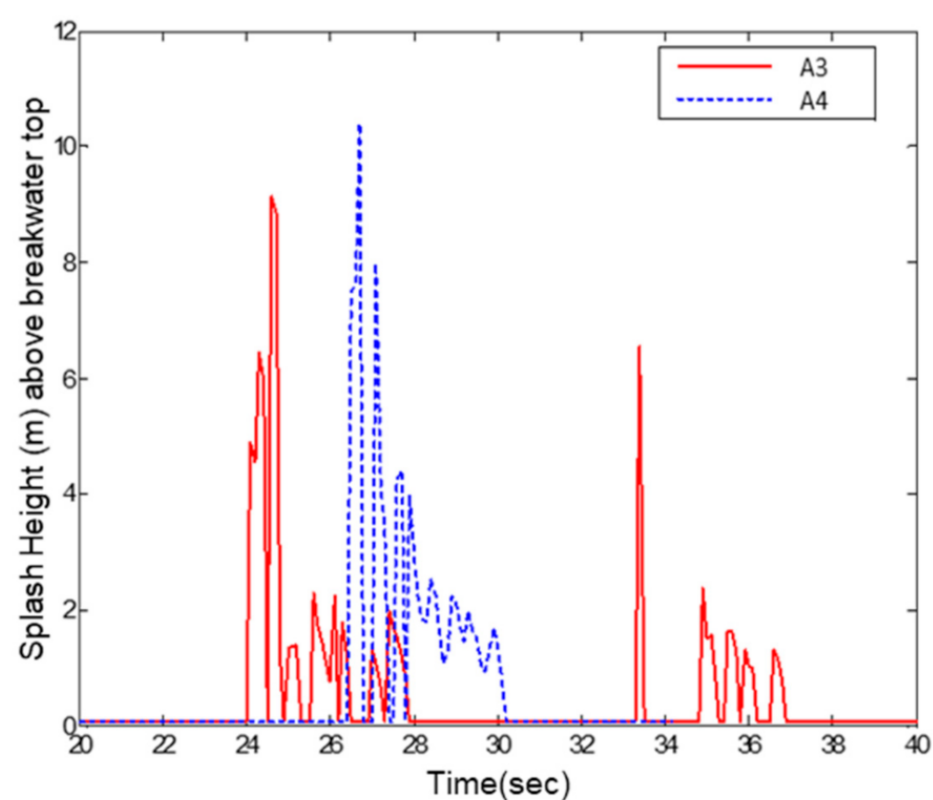
Figure 11. Time series of the splash height triggered by the CFW when armor blocks are installed (cases A3 and